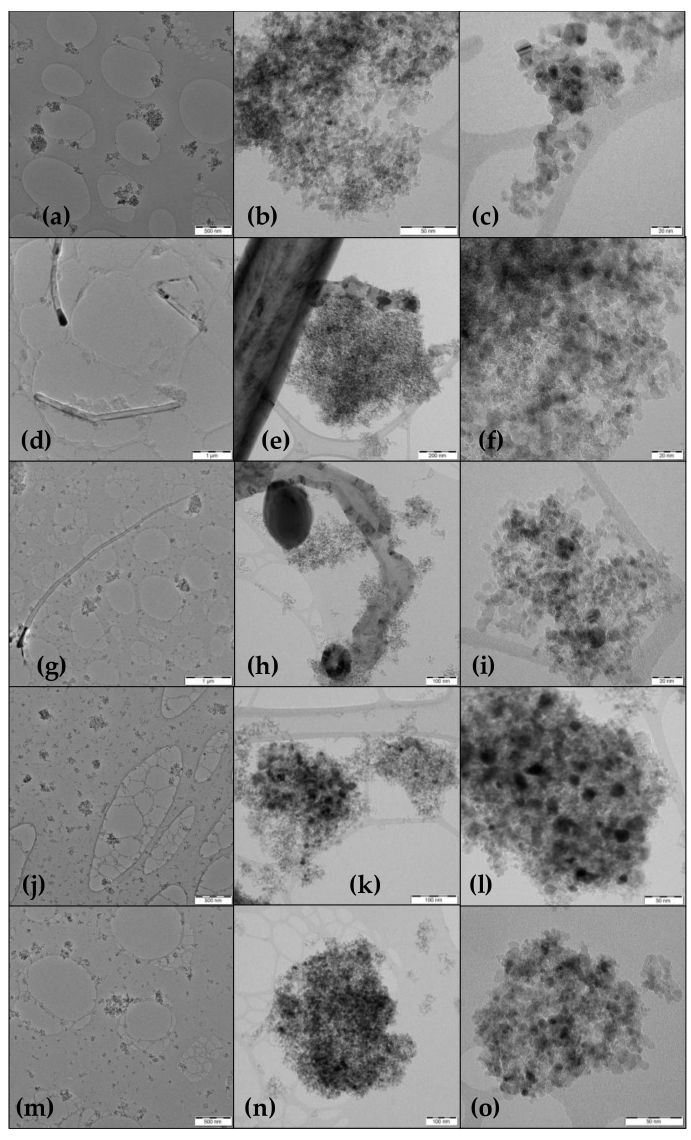
Figure 3. TEM images of the CP ( a – c ), NHD-1050 ( d – f ), NHD-900 ( g – i ), NHD-750 ( j – l ) and NHD-600 ( m – o ) samples at di ff erent